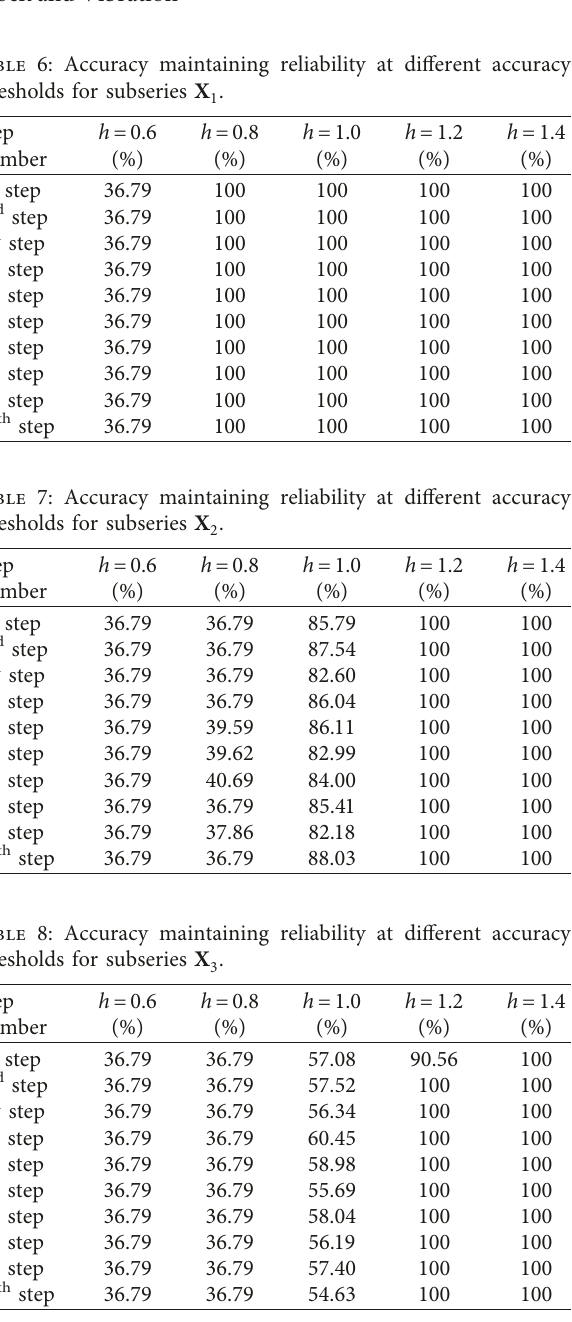
Table 6: Accuracy maintaining reliability at different accuracy thresholds for subseries X